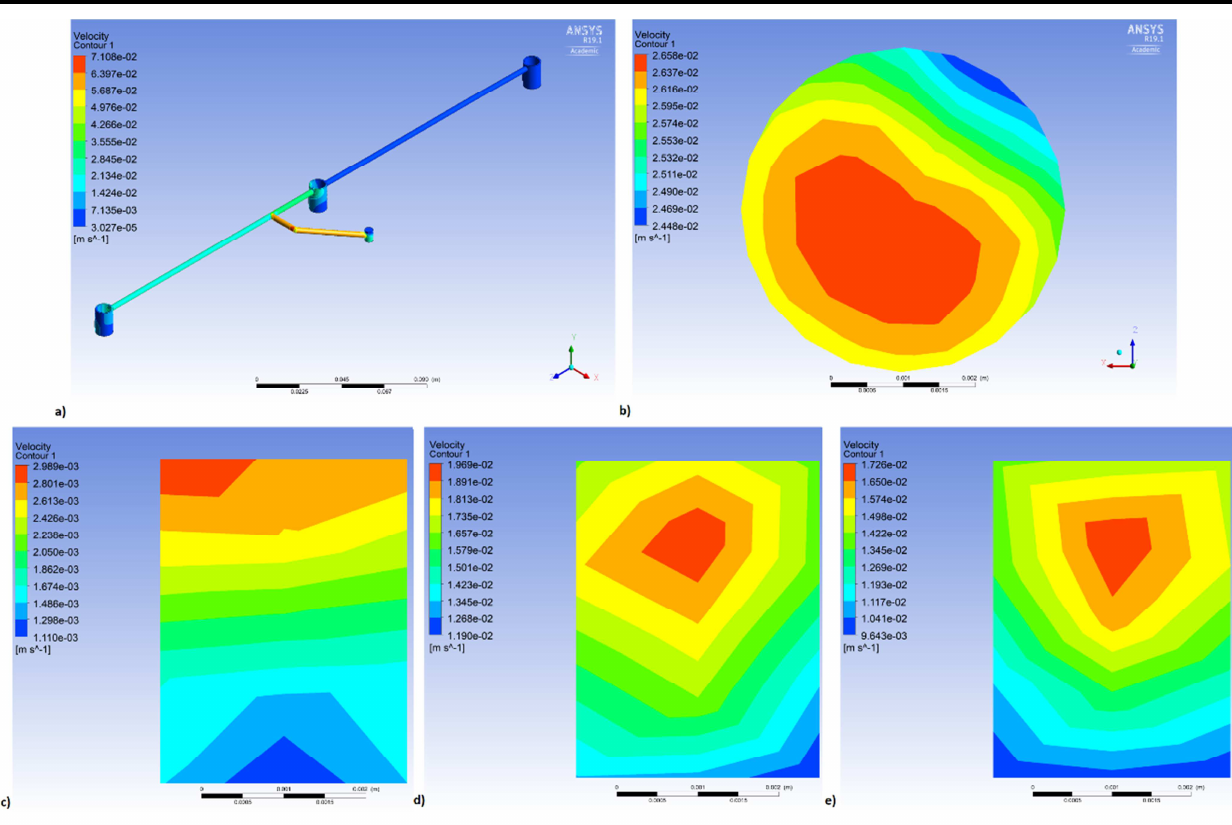
Fig. 11. Distributions of the oil flow velocity for the boundary condition on the inflow in the form of a constant pressure of 400 kPa a) for the oil main line, b) at the inlet, c) at the Outlet1, d) at the Outlet2, e) at the Outlet3